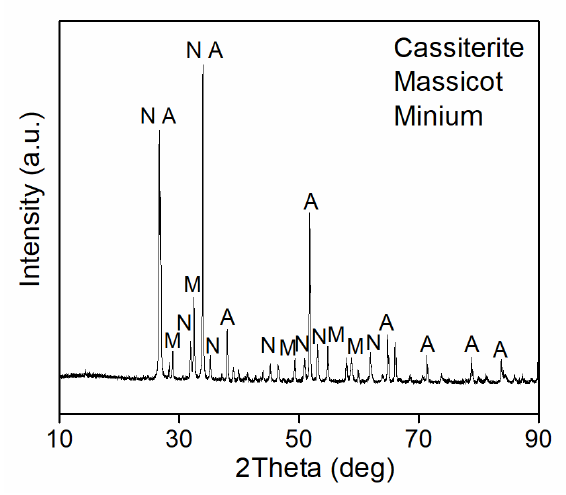
Figure A9. XRD result for burned tin and lead. Cassiterite (A), massicot (M), and minium (N) were identified.